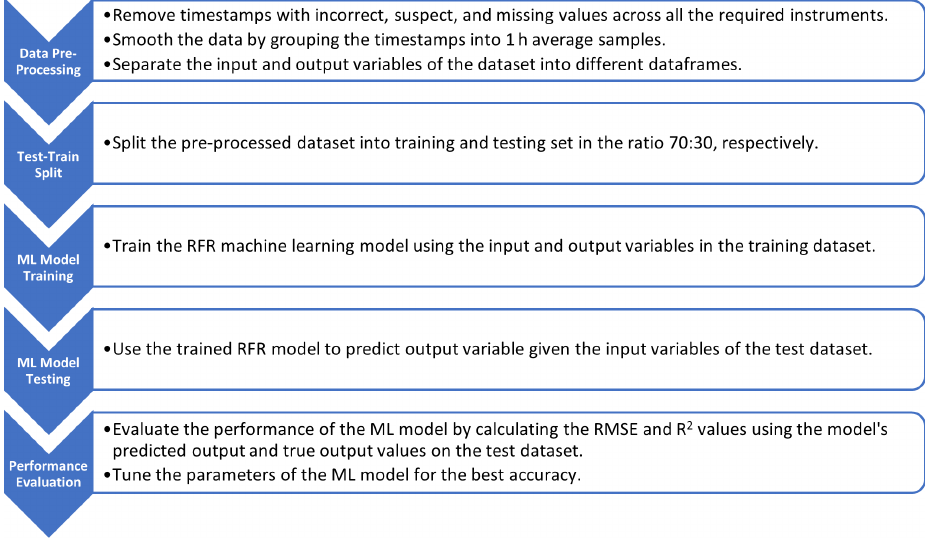
Code availability.